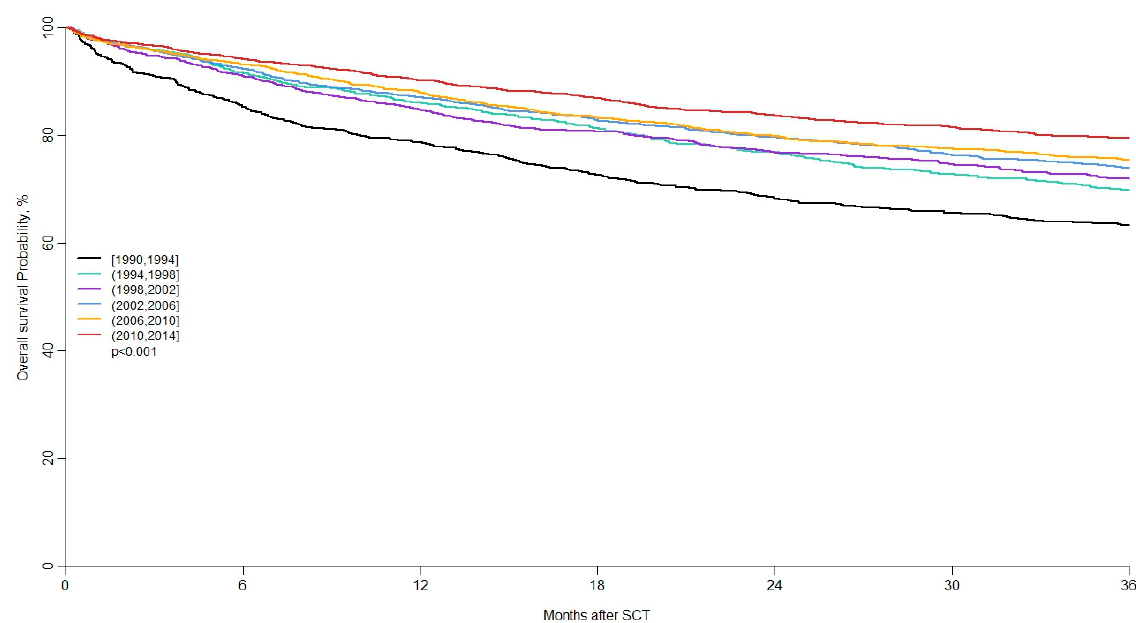
Figure 1. Long-term outcomes of auto-SCT in patients with r/r HL. Reproduced with permission [43], 2020.